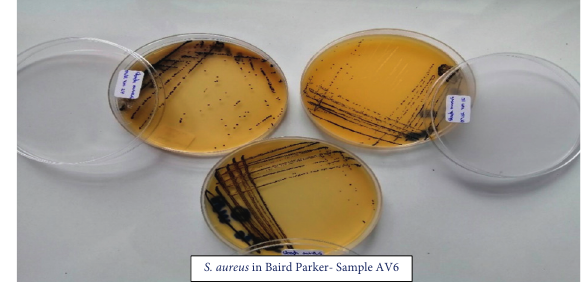
Figure 7: Staphylococcus aureus on Baird Parker media.